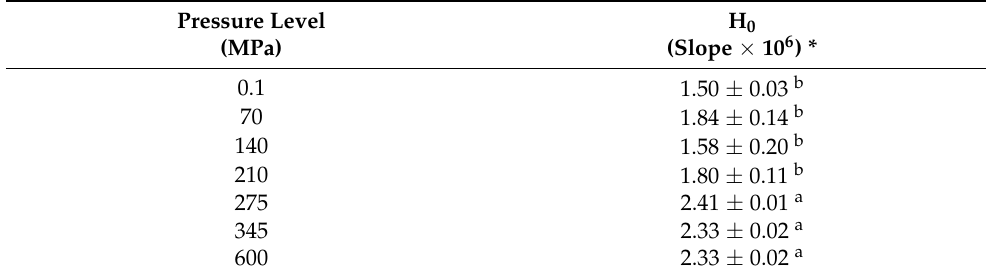
Table 1. Surface hydrophobicity (H 0 ) of control (0.1 MPa) and pressure-treated (70–600 MPa for 5 min) mealworm protein solutions.